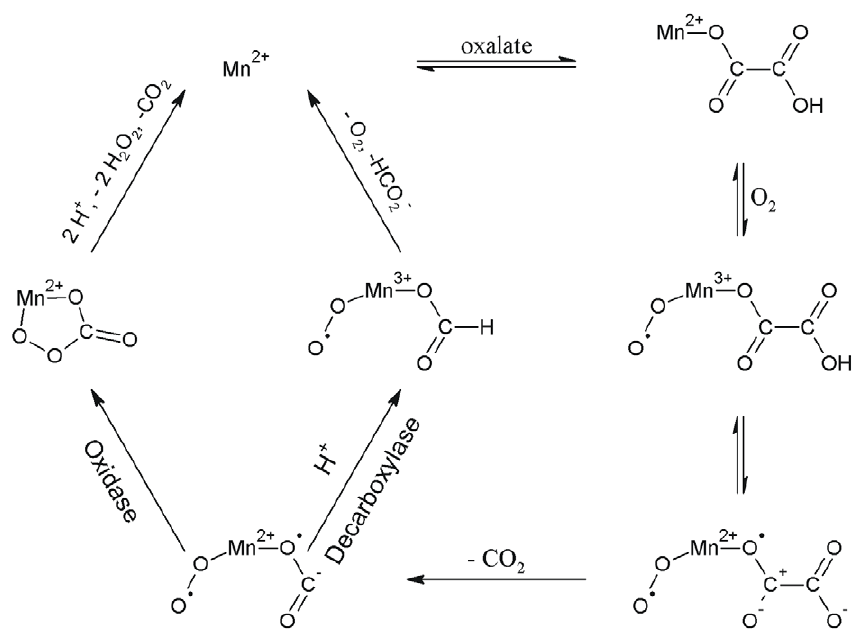
Figure 2. Model of free-radical mechanisms for oxalate oxidase and oxalate decarboxylase. Modified from [23].